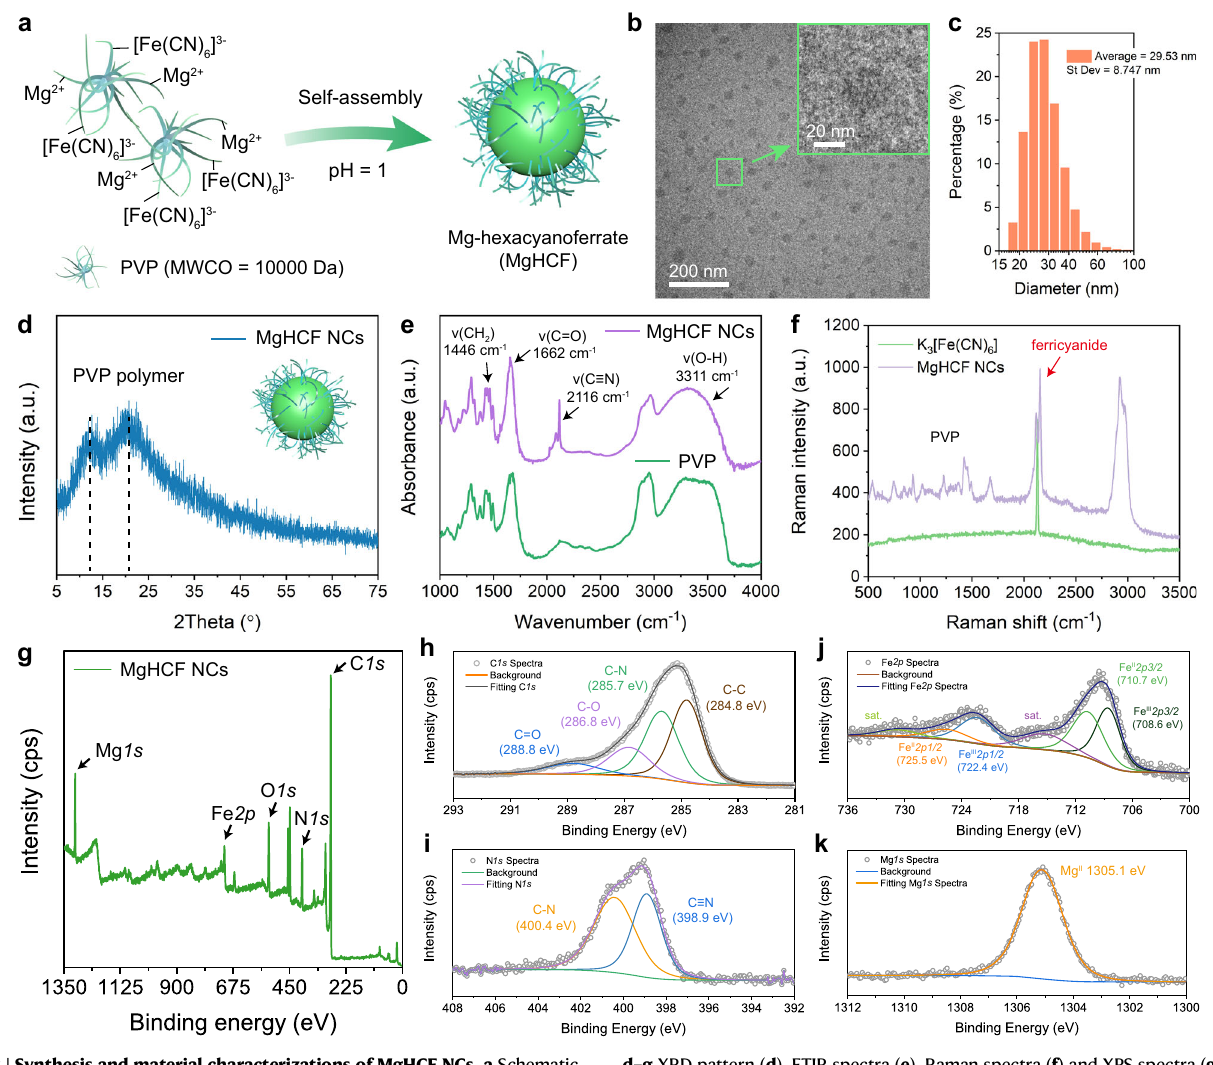
d – g XRD pattern ( d ), FTIR spectra ( e ), Raman spectra ( f ) and XPS spectra ( g )